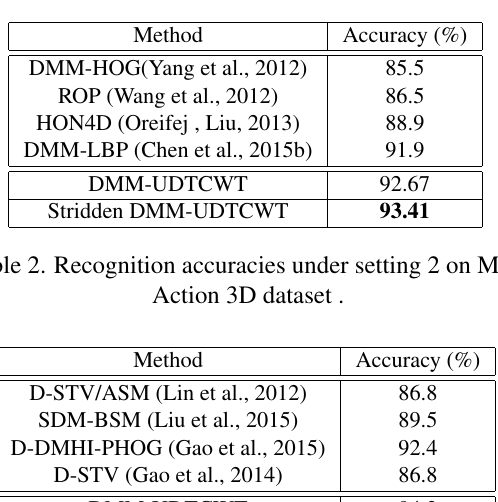
Figure 6. Confusion matrix under setting 2 on MSR Action 3D dataset demonstrating the class-wise recognition accuracy.